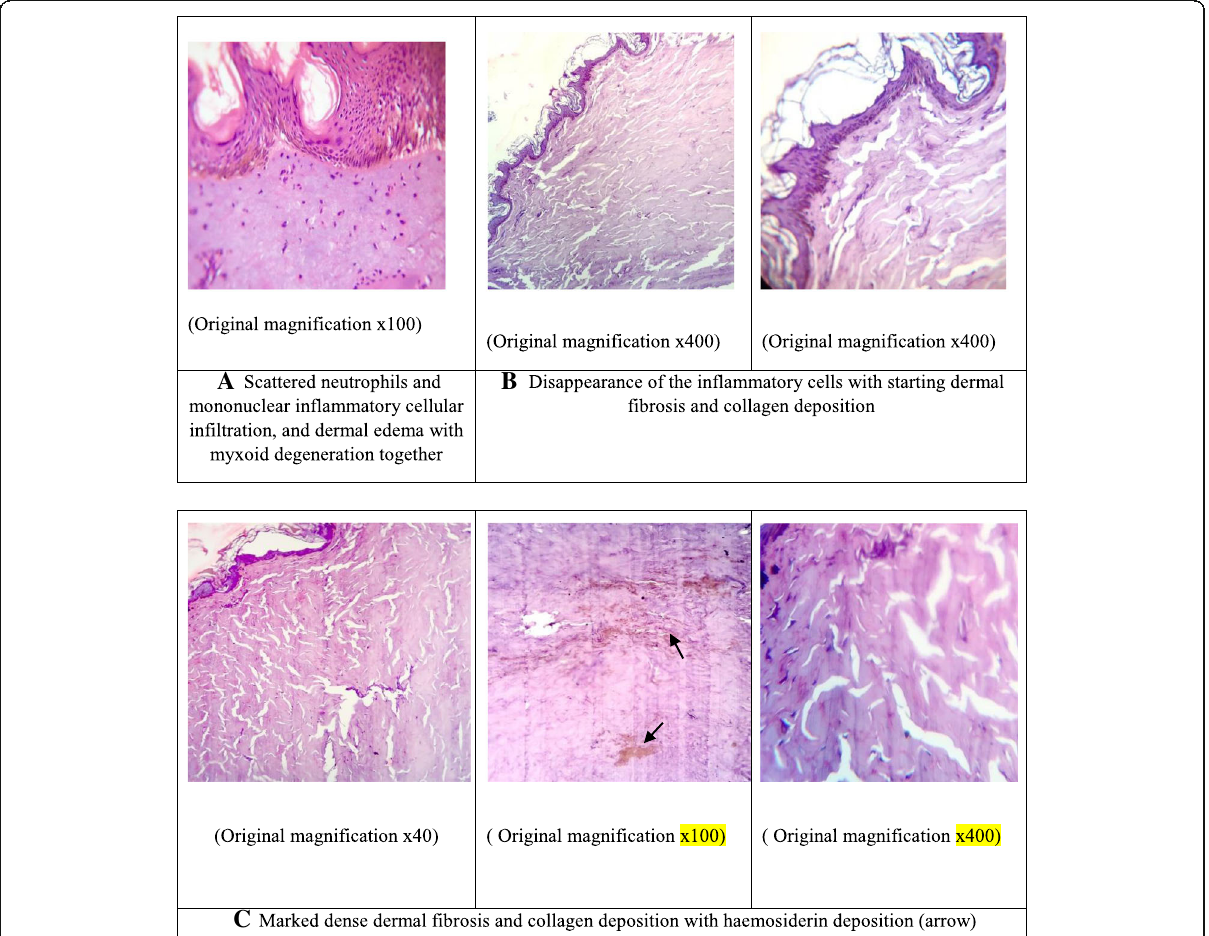
Fig. 1 Photomicrograph of skin specimen in group I ( a ), group II ( b ), and group III ( c